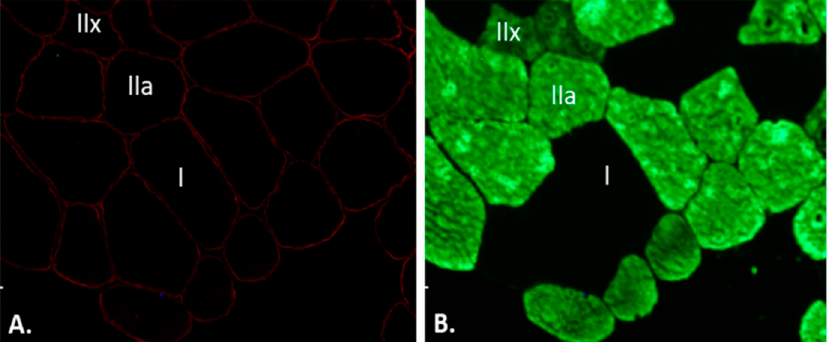
Figure 2. Immunofluorescence of the cross-sectional area of muscle fibres biopsied 10 days before the plyometric jump training. Dual immunofluorescence staining with anti-dystrophin ( A ) and anti-myosin heavy chain II ( B ) was performed. IIx indicates MHC-IIx-positive fibres; IIa indicates MHC-IIa-positive fibres; I indicates MHC-I-positive fibres. Scale bars: 20 um.